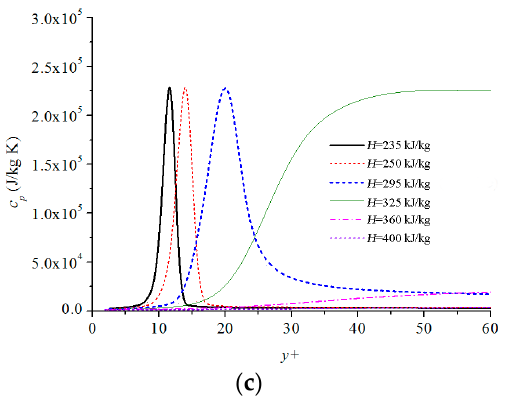
Figure 16. Variation of various parameters at low mass flux. ( a ) Relationship between the density gradient and y + ; ( b ) Relationship between the shear stress and y + ; ( c ) Relationship between the heat capacity and y + .